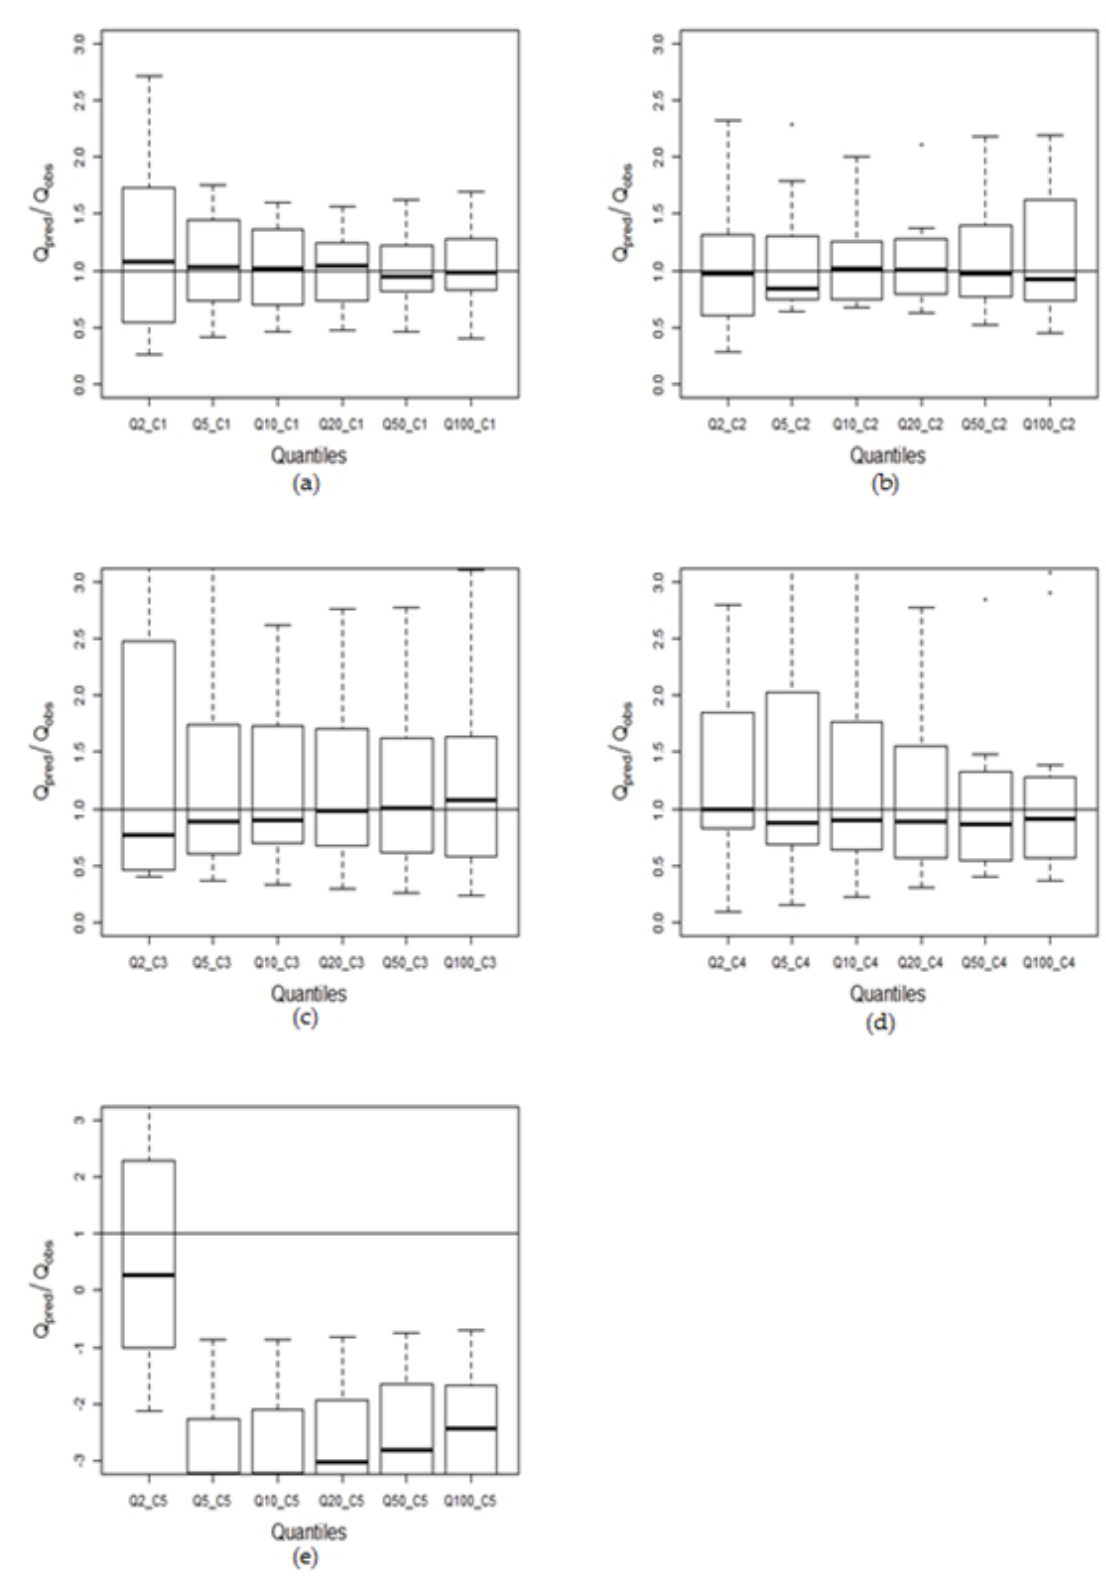
Figure 12. Boxplots of Q pred / Q obs ratios for all clusters and AEPs: ( a ) cluster 1 (C1); ( b ) cluster 2 (C2); ( c ) cluster 3 (C3); ( d ) cluster 4 (C4); and ( e ) cluster 5 (C5).